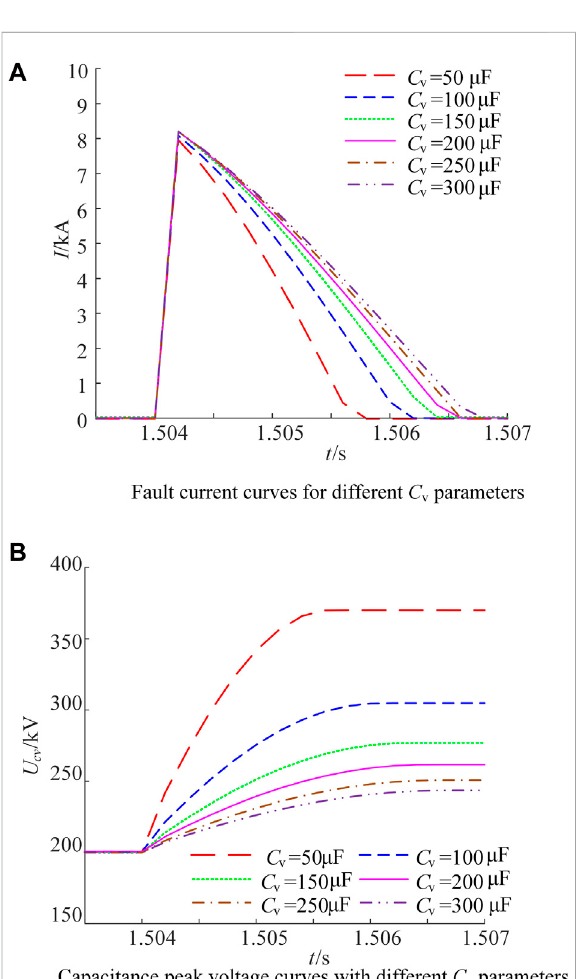
FIGURE 6 Fault current and peak capacitor voltage curves for different C v parameters.